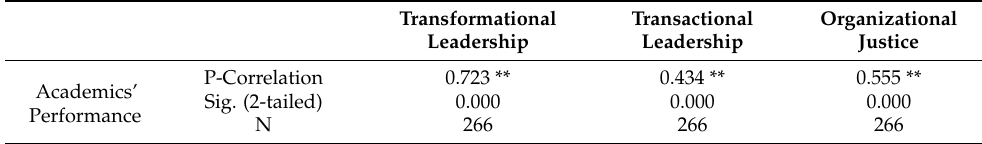
Table 4. Association